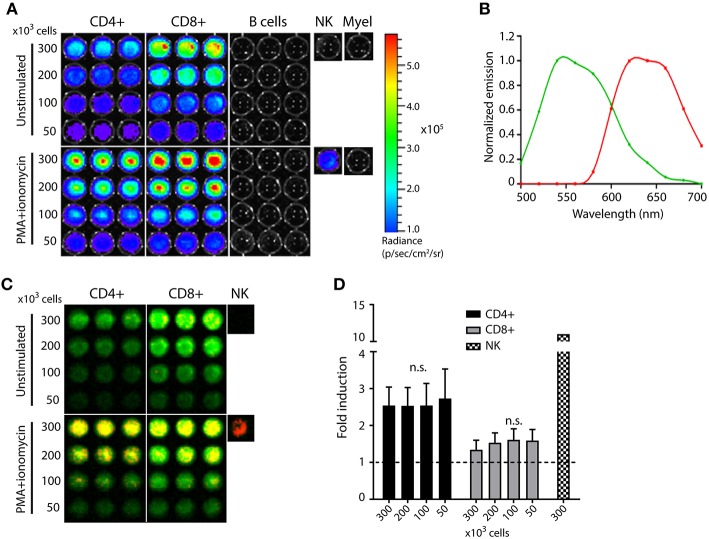
T cell-specific expression of constitutive and inducible luciferases in the TbiLuc mouse. T cells, B cells, NK cells, and myeloid cells were isolated from the spleen of TbiLuc mice, plated in different numbers, and stimulated overnight with PMA + ionomycin to activate the NFAT-inducible red luciferase. Representative data from two independent experiments. (A) Luciferase expression is restricted to CD4 and CD8 T cells and signal strength correlates to the number of T cells, both in unstimulated (top half) and PMA+ionomycin stimulated cells (bottom half). (B) Spectral unmixing of the total BLI signal identifies two emission spectra matching the constitutive CBG99 luciferase (green) and the NFAT-inducible PpyRE9 luciferase (red). (C) Spectral unmixing applied to the signals from Figure A indicates that naïve T cells express only constitutive CBG99 luciferase (top half, green color), while activated T cells express both luciferases (bottom half, overlay of green and red signals yielding yellow). NK cells produce PpyRE9 after stimulation but do not express CBG99 luciferase. (D) Fold induction of NFAT-luciferase expression in TbiLuc cells after PMA+ionomycin stimulation compared to unstimulated cells. Signals are corrected for differences in constitutive hCD2-luciferase expression. Baseline expression (1-fold) is indicated by the dotted line. Representative data of two independent experiments with n = 3 samples per group each (n = 1 for NK cells). Mean + SD, the fold induction within a cell subset is independent of cell number as there are no significant differences within CD4 T cells or within CD8 T cells (one-way ANOVA).